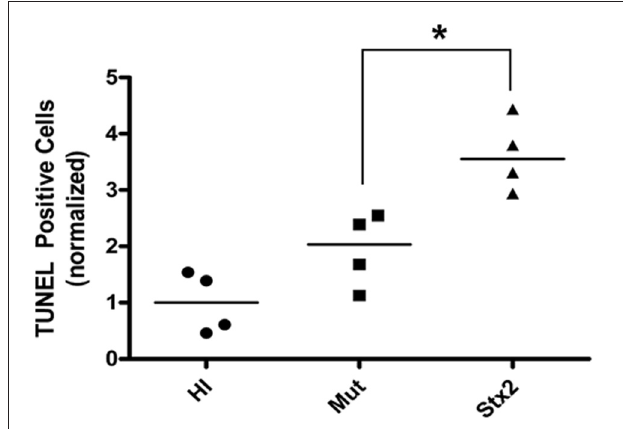
FIGURE 4 | Tissue sections from HI, Mut, and Stx2-treated animals ( n = 4 for each from a single litter) were analyzed for apoptotic events by TUNEL staining. For a given experiment, the number of apoptotic cells were counted per unit area and then normalized against those of the HI-treated animals. The normalized values are shown for each individual animal along with the median (horizontial line). ∗ Significance as determined by the Mann–Whitney U -test P = 0 . 029.